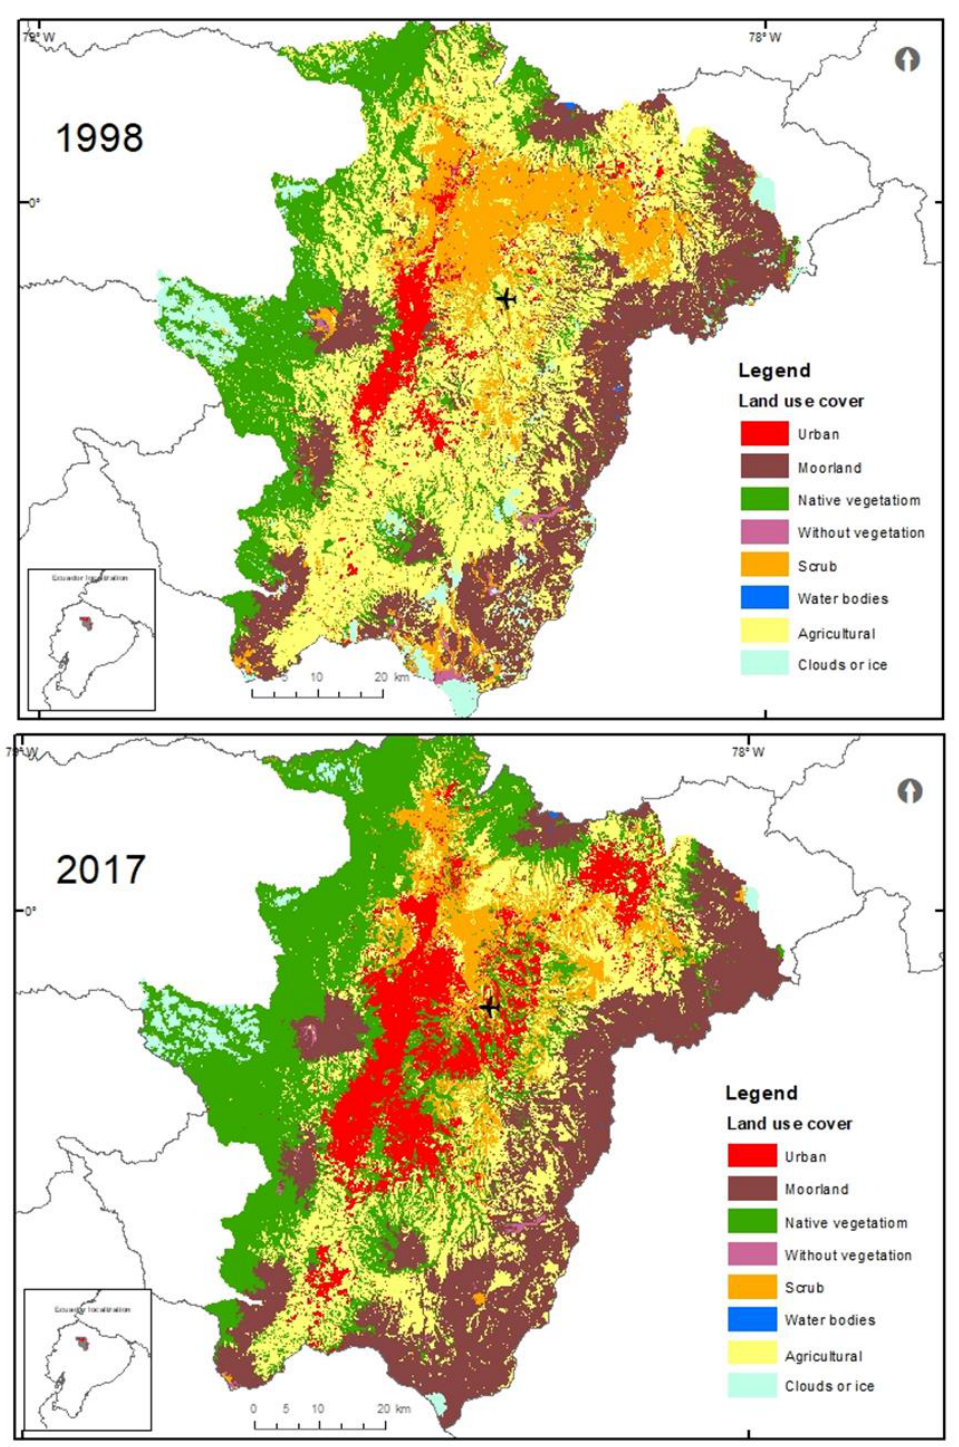
Figure 4. Land use and land cover: 1998 in contrast to 2017. Table 2. Land use and land cover in the New Metropolitan Area of Quito (NAMQ), 1998 and 2017. ha ha